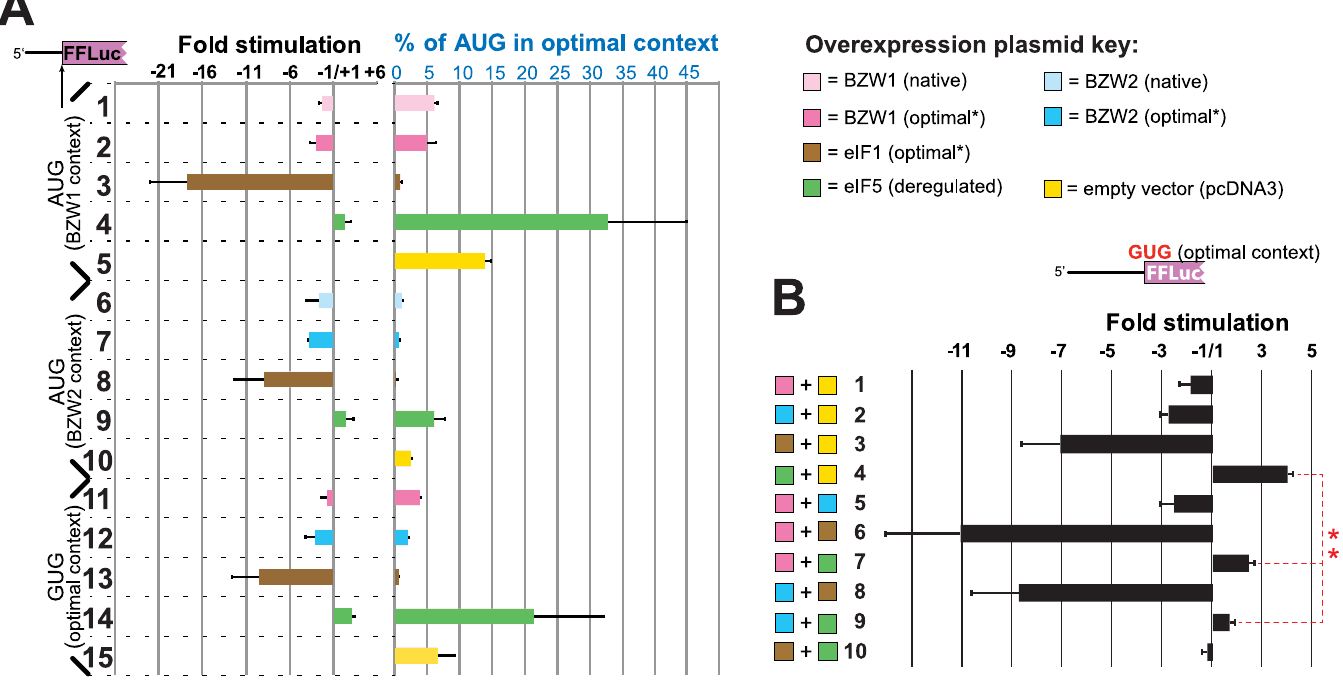
Fig 3. Overexpression of BZW1 and BZW2 leads to higher stringency of start codon selection and cancels the effect of eIF5 overexpression. (A) Dual luciferase assays showing fold stimulation (left-hand side) or percentage initiation relative to AUG in optimal context (right-hand side) of firefly luciferase reporters initiated with start codons in native BZW contexts or with GUG as indicated (left-hand margin) in response to overexpression of the indicated initiation factors. (B) Dual luciferase assays showing fold stimulation of GUG-initiated firefly luciferase reporters in response to overexpression of combinations of the indicated initiation factors. For both (A) and (B), firefly luciferase measurements were normalized to those from a co-transfected Renilla luciferase expressing construct. For the fold stimulation calculations, the ratios in test cells were compared to the luciferase ratio in control cells transfected with pcDNA3. Negative "stimulation" values indicate repression. “Optimal (cid:3) ” indicates initiation context which is optimized at nucleotide positions − 6 to − 1 relative to the start codon, but not at position +4 which is kept the same as the native sequence to prevent changes in the encoded amino acid. (cid:3)(cid:3) p < 0.001 (Student’s two-tailed t -test, n = 6).